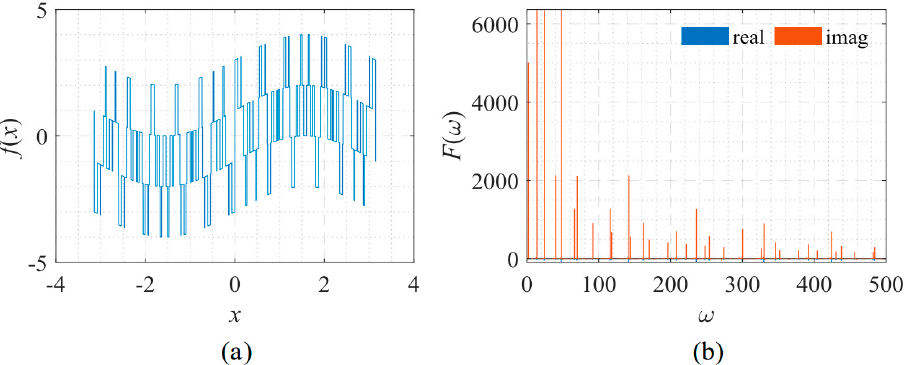
Figure 22. Signal described by Equation (14) with its frequency spectrum. ( a ) The function to be fitted. ( b ) The spectrum of the function.